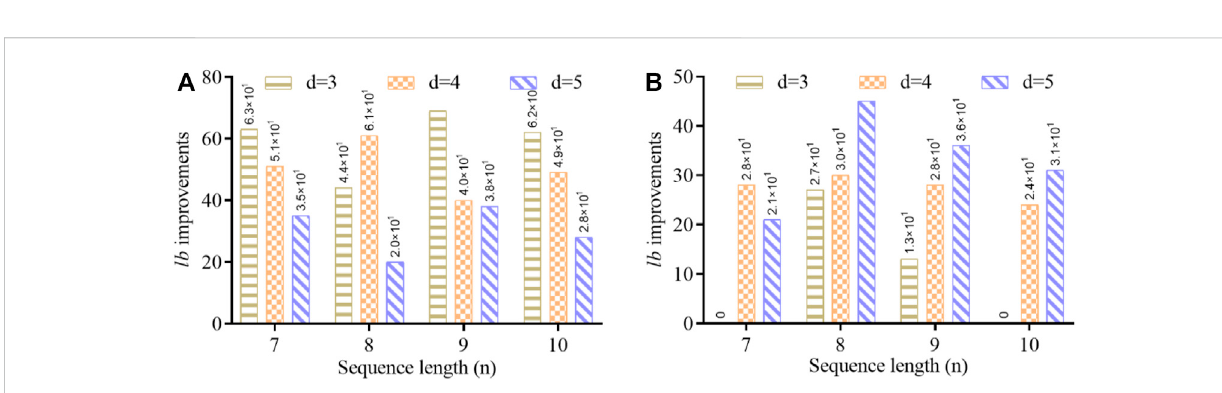
FIGURE 5 Comparison of improved lower bounds (lb) with different sequence lengths based on (A) Table 3 and (B) Table